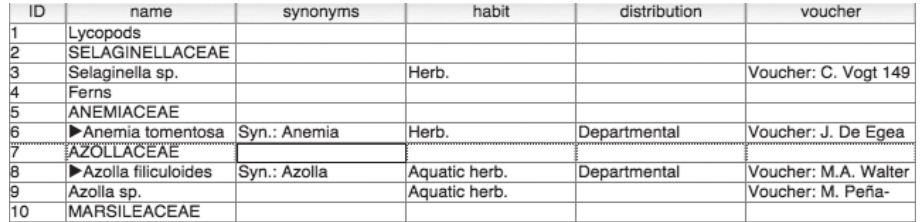
Figure 4. Data correctly aligned with columns.